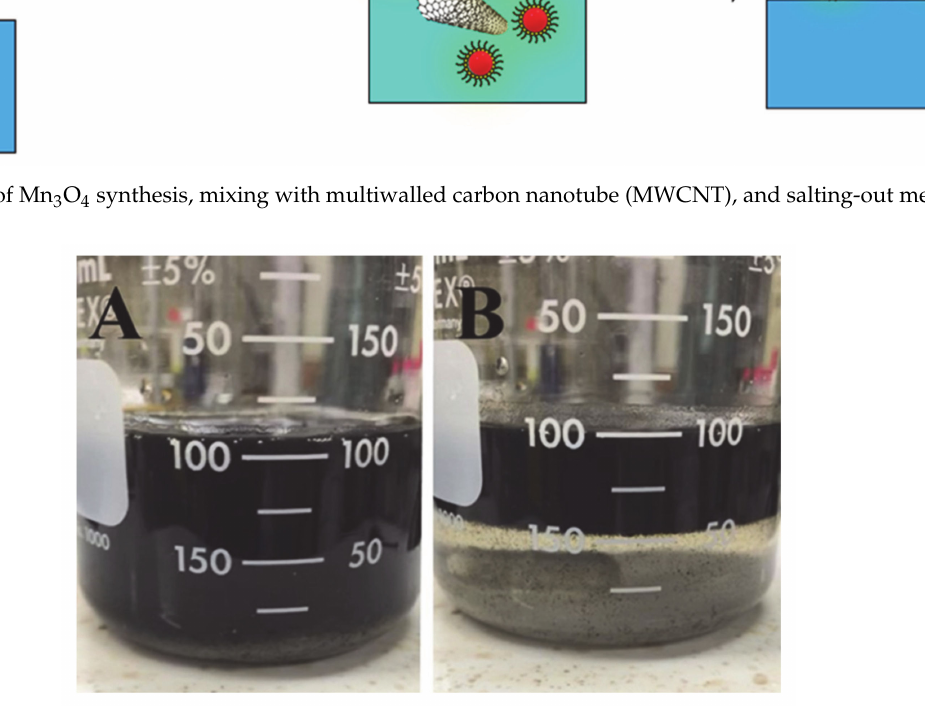
Figure 3. Suspension of Mn 3 O 4 and MWCNT dispersed using octanohydroxamic acid (OHA) in a mixed water-2-propanol solvent ( A ) before and ( B ) after adding